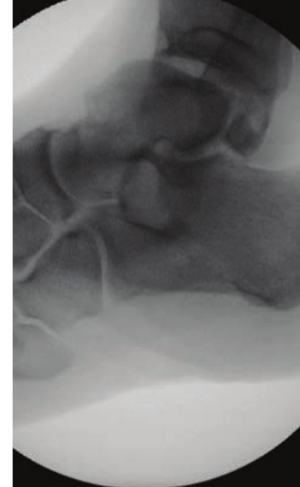
Figure 3. Talar shift on stress